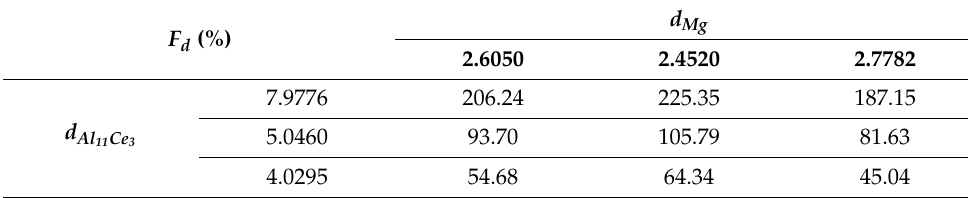
Table 6. The crystal surfaces mismatch between α -Mg and Al 11 Ce 3